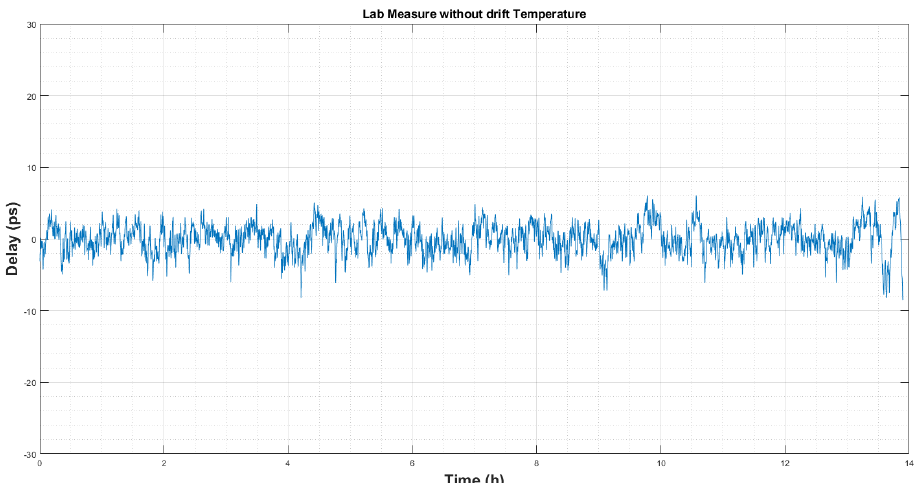
Figure 11. Delay measurement in the laboratory after drift removal by curve